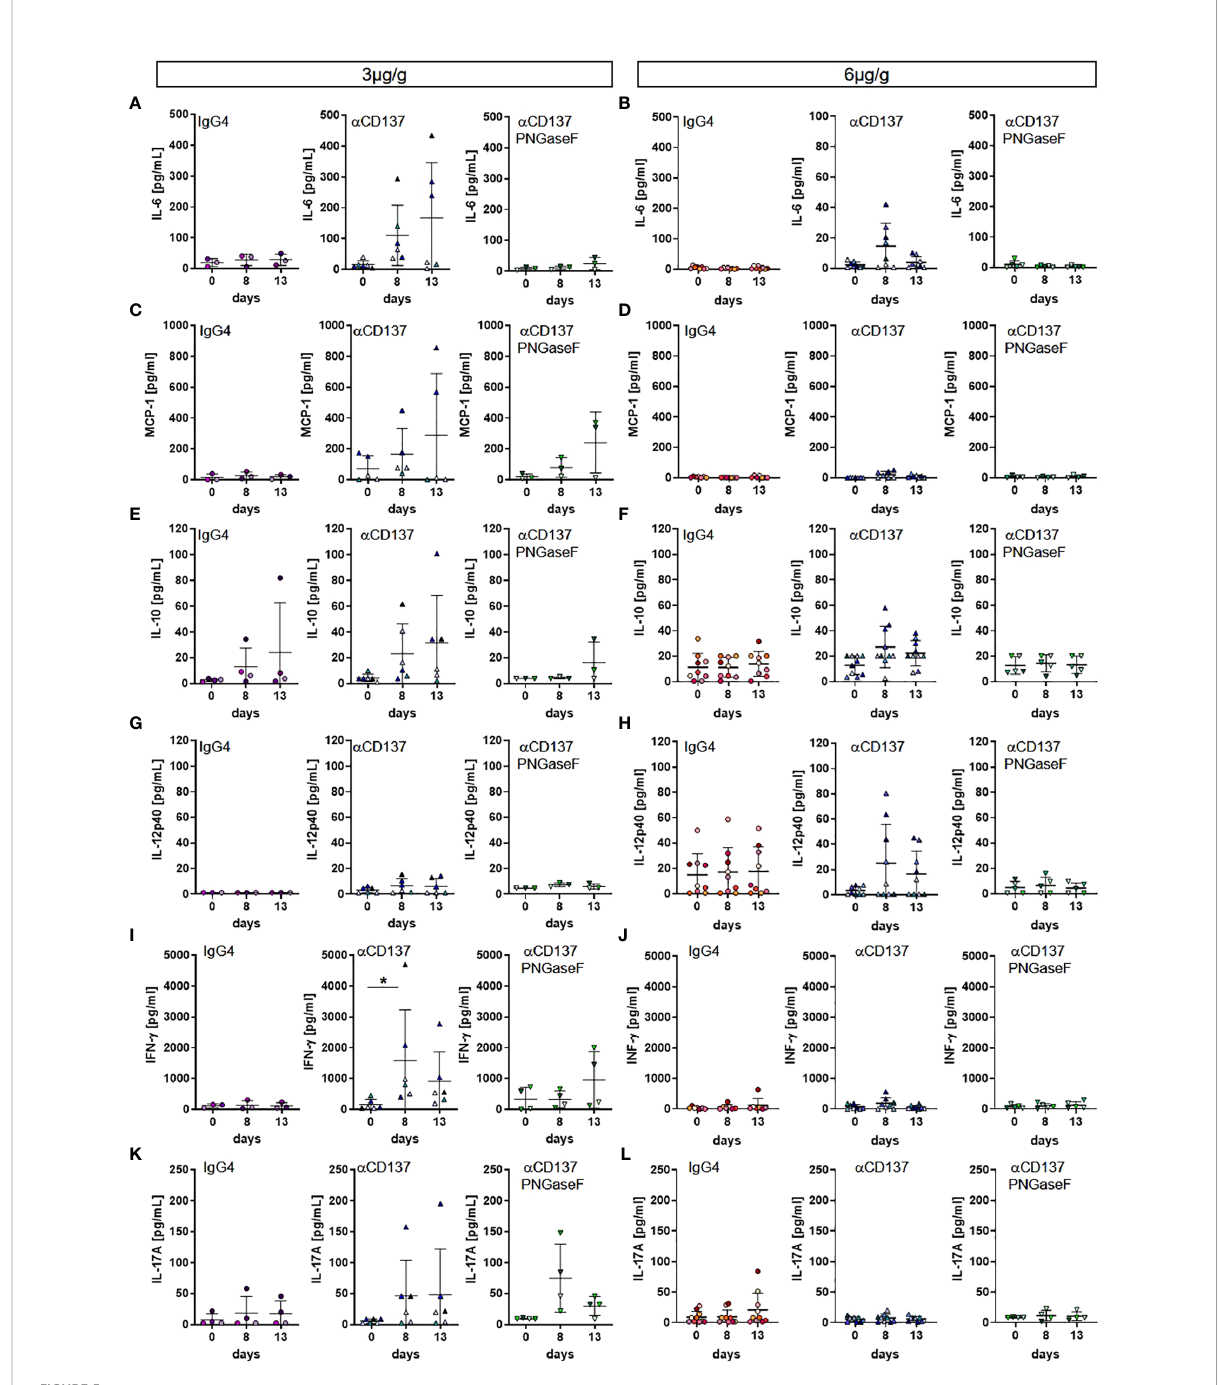
FIGURE 5 Effect of urelumab treatment dose and glycosylation on serum cytokine levels in humanized mice. Humanized mice received either 3 or 6µg/g of a human IgG4 isotype control, urelumab ( a CD137) or deglycosylated urelumab ( a CD137 PNGaseF) and serum samples were collected before and at 8 and 13 days after antibody injection. Shown are concentrations of serum cytokine levels before and at the indicated time-points after injection of 3 (A, C, E, G, I, K) or 6 (B, D, F, H, J, L) µg/g. Depicted are serum concentrations of IL-6 (hIgG4: n=3-8, a CD137: n=6-8, a CD137 PNGaseF: n=3-5) (A, B) , MCP-1 (hIgG4: n=3-7, a CD137: n=5-7, a CD137 PNGaseF: n=3-4) (C, D) , IL10 (hIgG4: n=4-9, a CD137: n=6-10, a CD137 PNGaseF: n=3-5) (E, F) , IL12p40 (hIgG4: n=3-9, a CD137: n=6-9, a CD137 PNGaseF: n=3-5) (G, H) , IFN g (hIgG4: n=3-7, a CD137: n=6-8, a CD137 PNGaseF: n=4-5) (I, J) , and IL17A (hIgG4: n=4-8, a CD137: n=6-9, a CD137 PNGaseF: n=4) (K, L) . Results are expressed as mean +/-SD. Statistical analysis was done using ROUT outlier test (Q=1%) and Shapiro-Wilk normality test. For graphs showing serum concentration of cytokines either Friedman test with Dunn ’ s multiple comparison test or RM-One-Way ANOVA with Tukey ’ s multiple comparison test was performed.